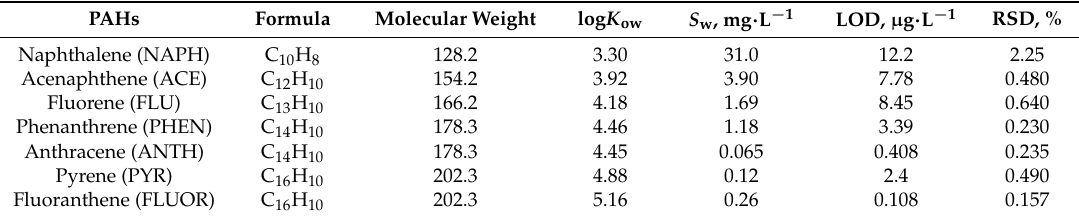
Table 1. Properties and detection of selected polycyclic aromatic hydrocarbons